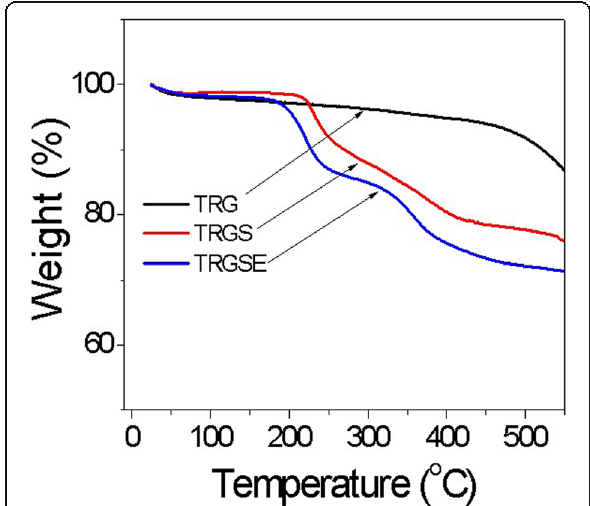
Fig. 3 The thermal gravimetric analysis for TRG, TRGS, and TRGSE